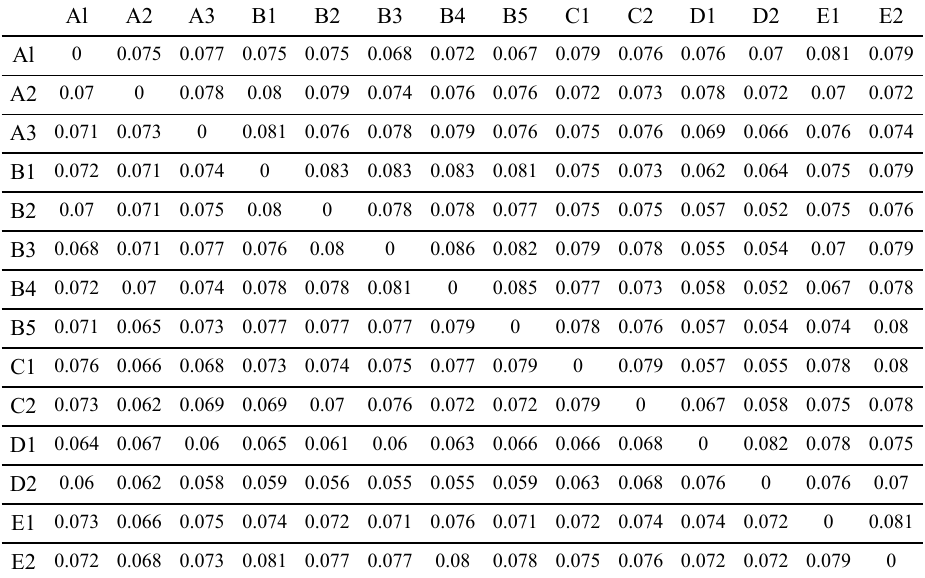
Table 8. The normalized initial direct-relation matrix